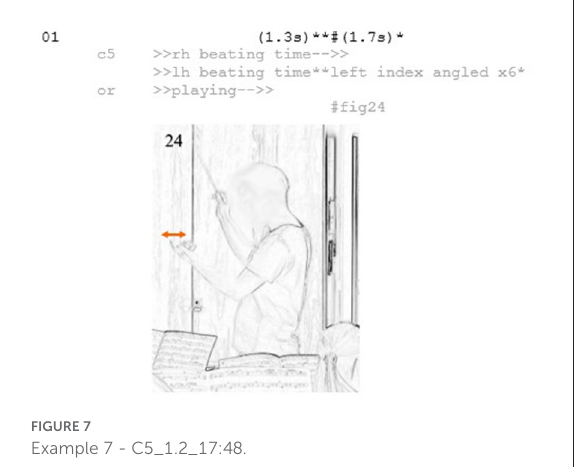
FIGURE7 Example 7 -